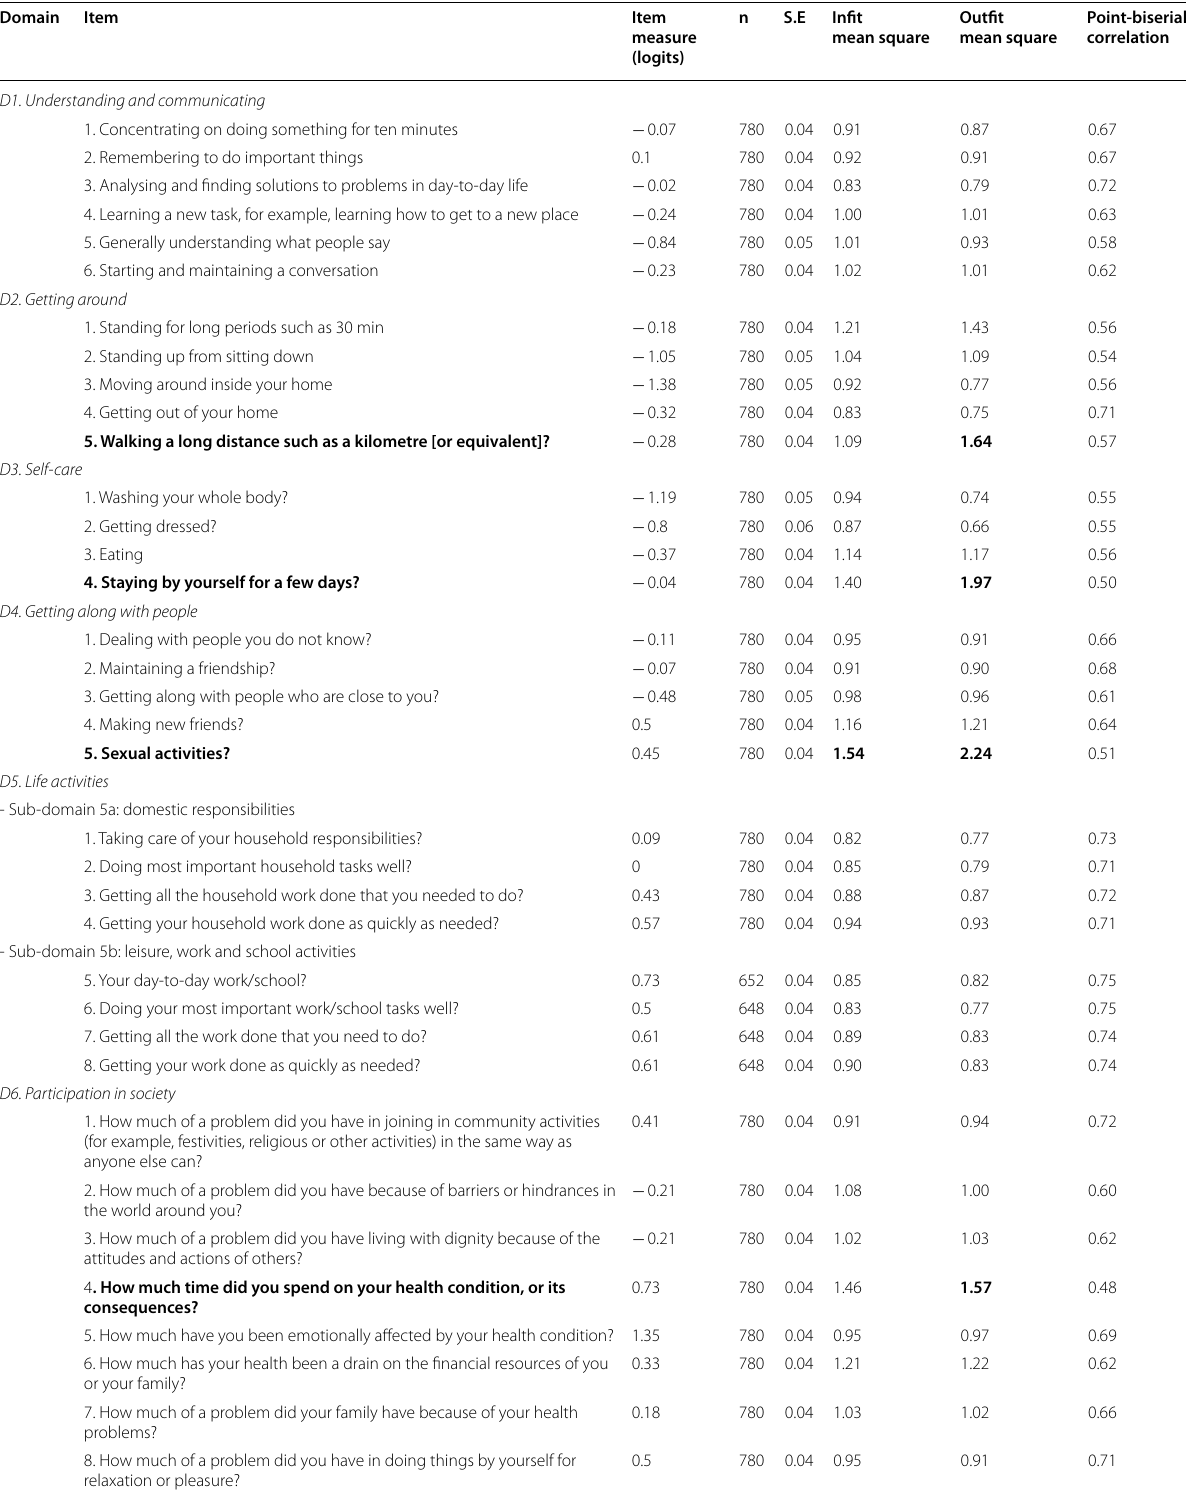
Table 2 Fit statistics for the Swedish 36-item version of WHODAS 2.0 Domain